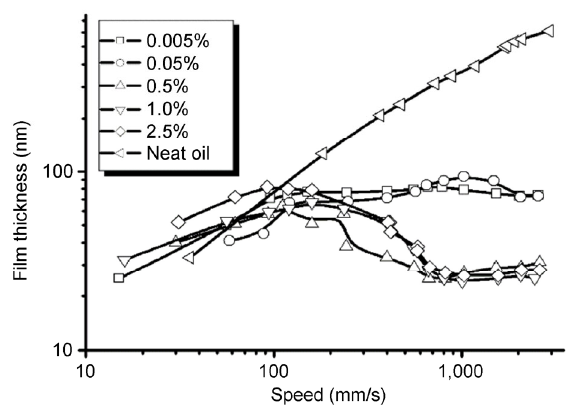
Fig. 24 Film formation of aqueous emulsions with oil con- centrations measured by Ma et al. [119]. Copyright 2009, Elsevier B.V.